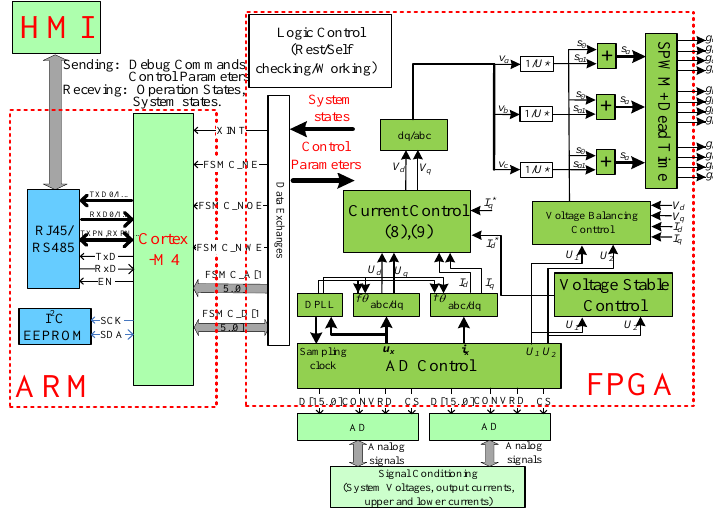
Figure 15. Realization diagram of the control system.